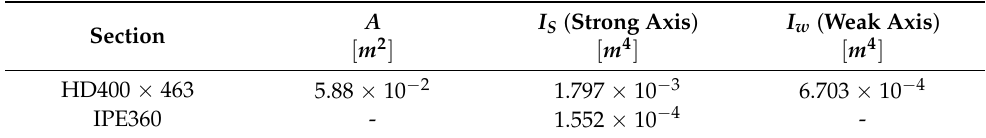
Figure 1. The case study: 3d view ( a ), an external frame ( b ) and an internal frame ( c ). Table 1. Geometrical properties of the frame